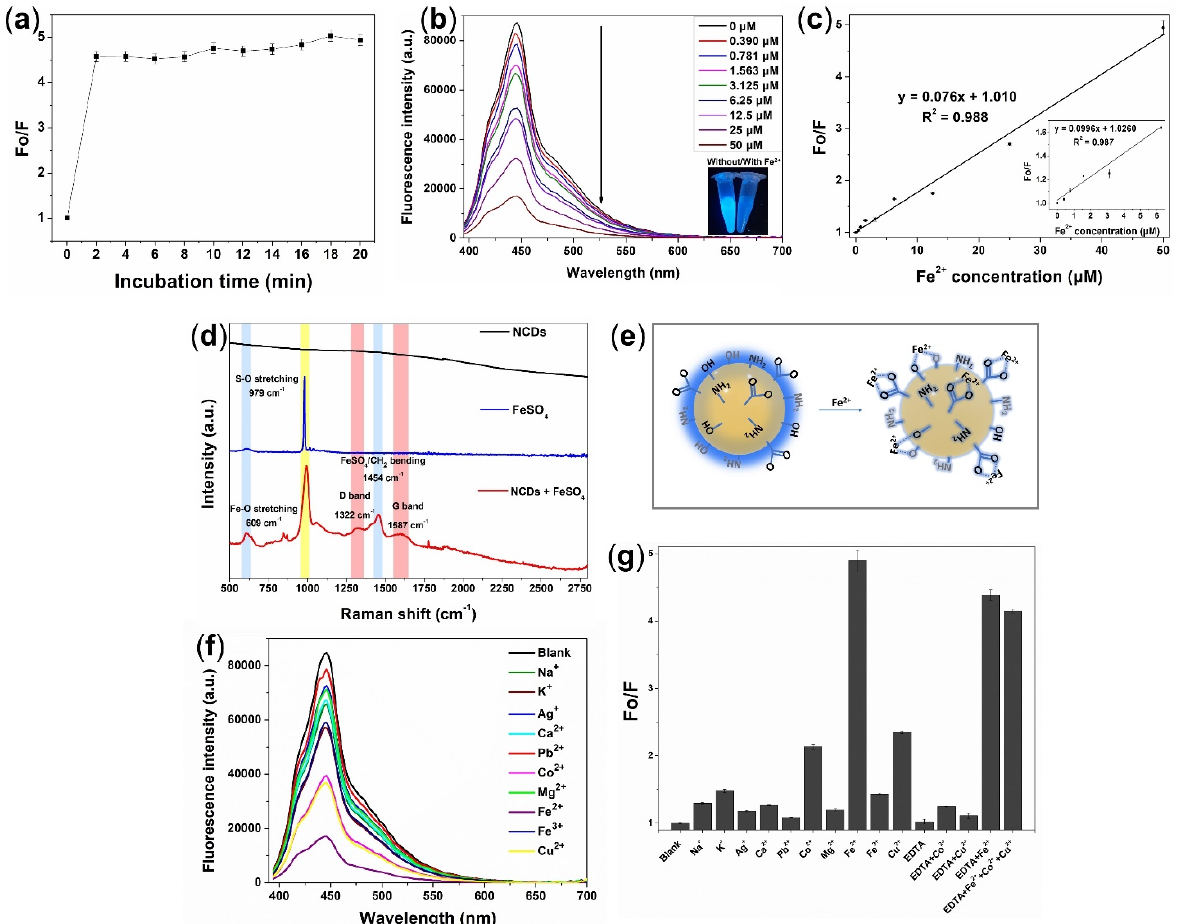
Figure 4. ( a ) Fluorescence quenching efficiency of NCDs in the presence of Fe 2+ at different incubation time. ( b ) Fluorescence quenching spectra under 365 nm excitation in the presence of increasing concentrations of Fe 2+ ion of (0–50) µM. Inset: photographs of NCDs solution with/without ferrous ion under UV light at 365 nm presents the quenching effect of Fe 2+ ion. ( c ) Linear correlation between Fe 2+ concentration of (0–50) µM and fluorescence quenching efficiency (Fo/F). Inset: linear relationship between Fe 2+ concentration of (0–6.25) µM and quenching efficiency with good linear calibration. ( d ) Raman spectra of NCDs, FeSO 4 , and NCDs with Fe 2+ ion reveal the charge–transfer fluorescence quenching by chelation between NCDs and Fe 2+ . ( e ) Schematic of chelating quenched fluorescence via Fe 2+ chelation and electron transfer. ( f ) Fluorescence spectra of NCDs after addition of various metal ions. ( g ) Quenching effect of different ions on fluorescence of NCDs.